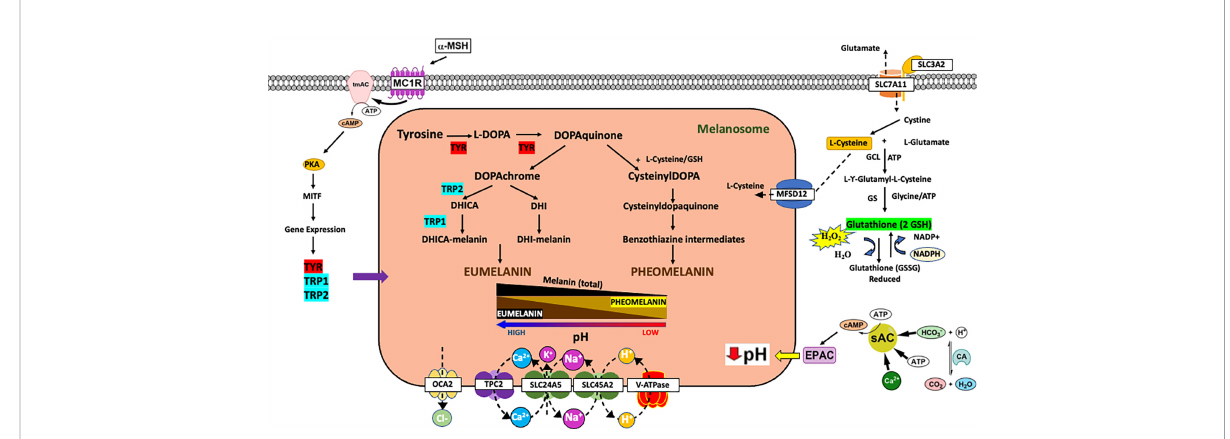
FIGURE 1 Impact of melanin metabolism on oxidative stress in melanoma. Overview of mechanisms of controlling melanin synthesis via gene expression or control of melanosome pH. Schematic of tyrosine metabolism in the cell highlighting the impact of melanin metabolism on oxidative stress. a-MSH, alpha melanocortin stimulating hormone; MC1R, melanocortin 1 receptor; tmAC, transmembrane adenylyl cyclase; PKA, protein kinase A; TYR, tyrosinase; TRP1, TYRP1/tyrosinase related protein 1; TRP2, TYRP2/DCT/tyrosinase related protein 2; EPAC, exchange protein activated by cAMP; sAC, soluble adenylyl cyclase; CA, carbonic